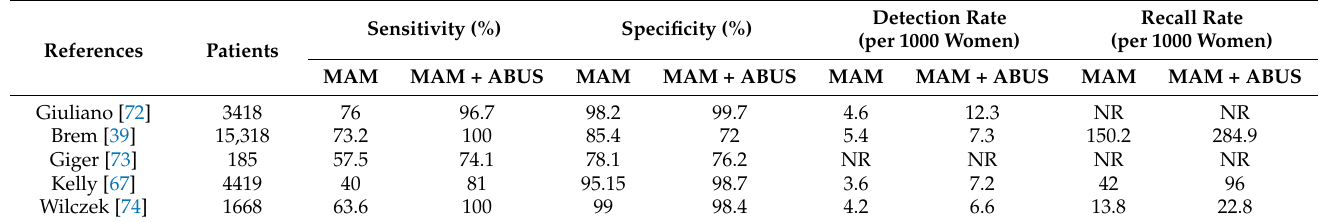
Table 2. Comparison of diagnostic metrics of MAM and MAM screening plus ABUS. Abbreviation: NR, not reported.